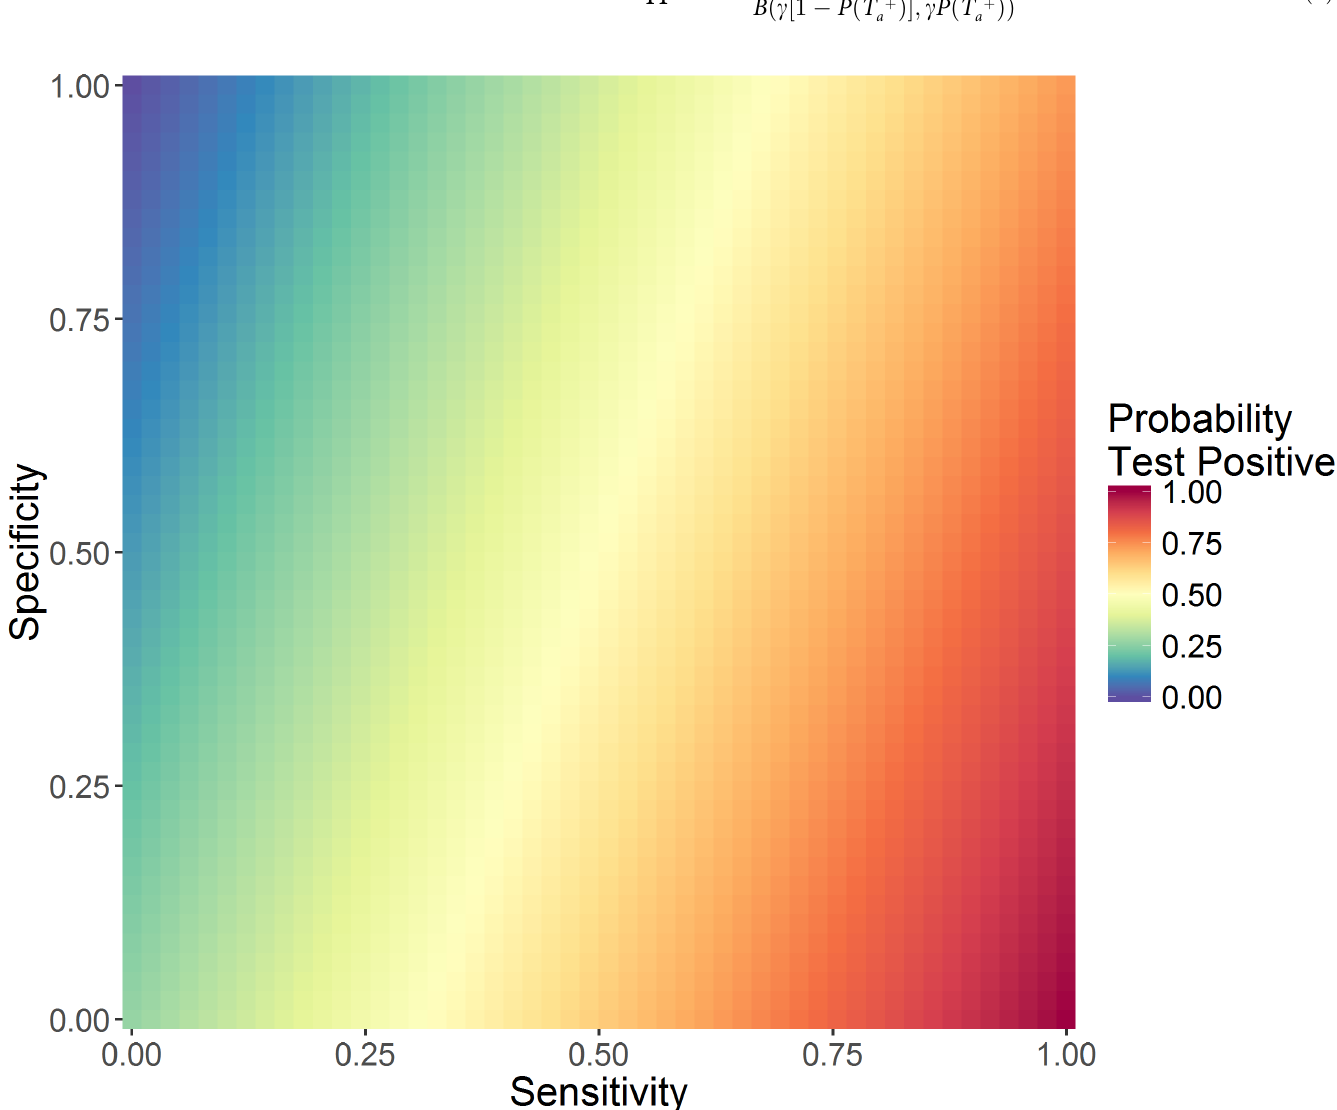
Fig 2. Probability of 9-year olds testing positive [P(T a+ )] for different test sensitivity and specificities, for a true probability of being seropositive of 0.7.